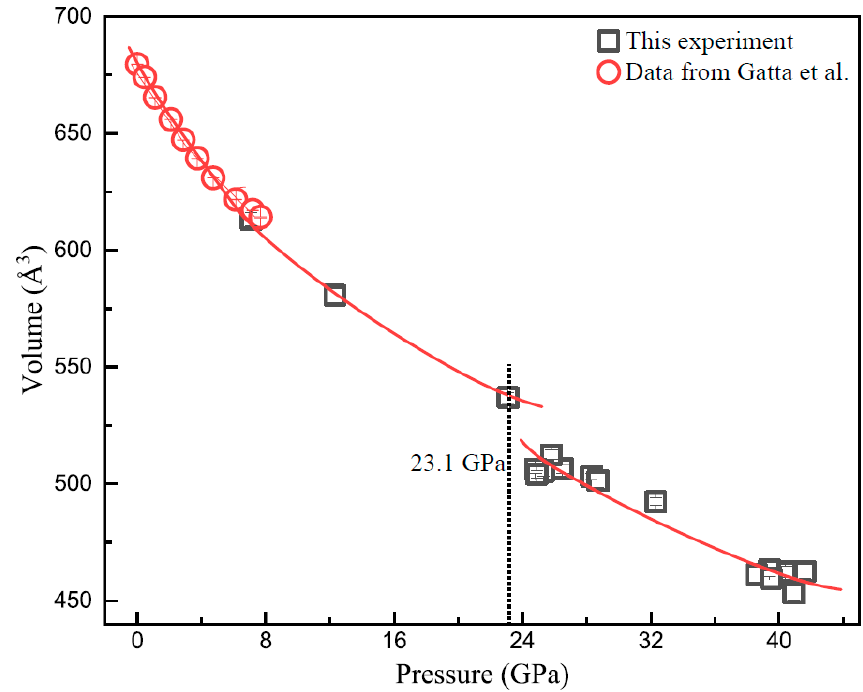
Figure 4. Compression curve of vanadinite with data from reference [13] and this experiment. The red lines are guides for eyes to show the discontinuous volume reduction around 23 GPa.